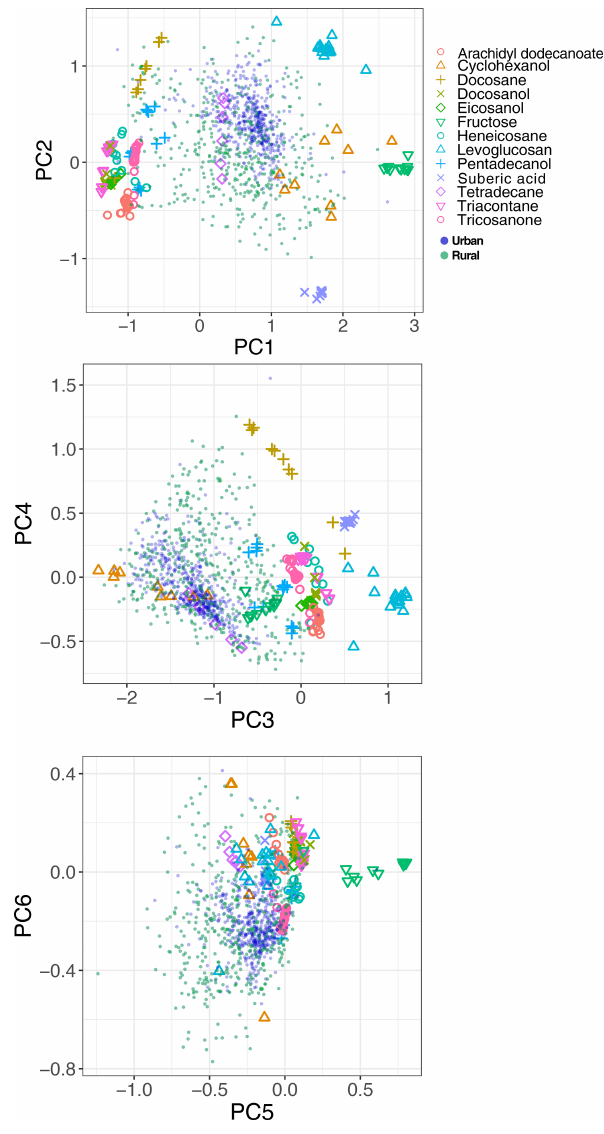
Figure 10. Bi-plots showing the scores of normalized spectra of laboratory standards (color) and normalized spectra of atmospheric samples (filled circles) projected onto the first six principal compo- nents calculated for laboratory standards and listed in Table